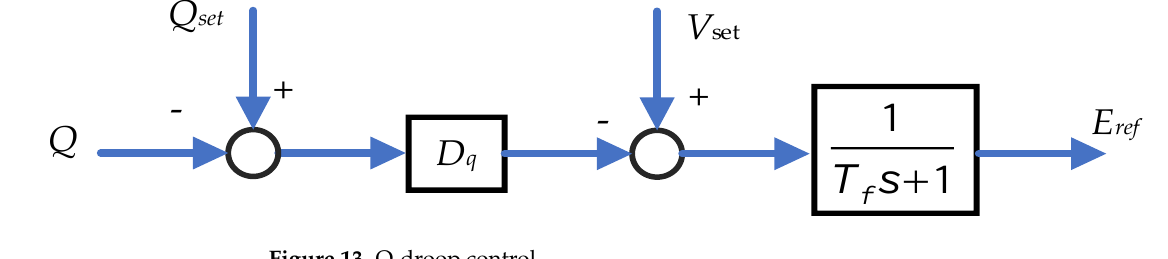
Figure 13. Q-droop control.